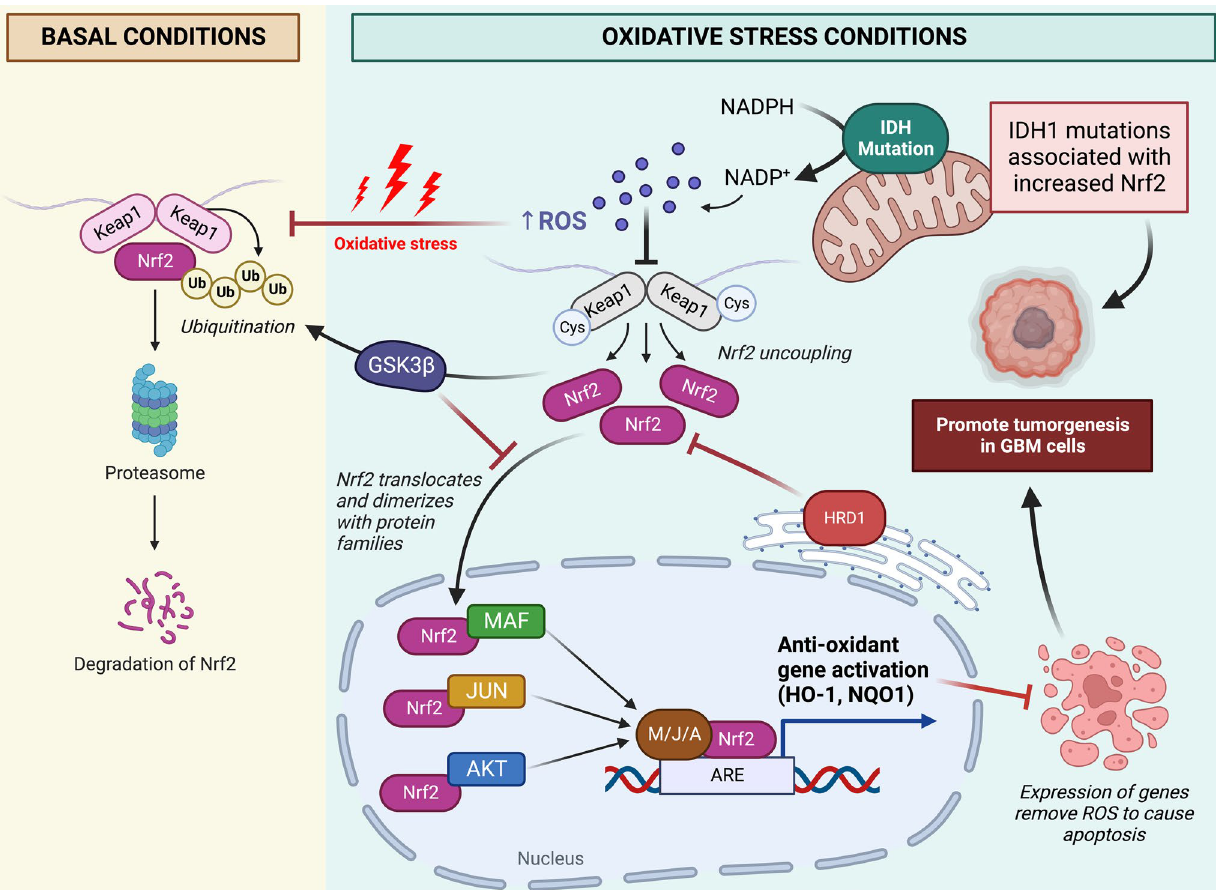
Fig. 2 A general overview of the Nrf2 pathway in basal conditions vs. oxidative stress and how it influences the pathogenesis of GBM. (Cre- ated with biorender.com)